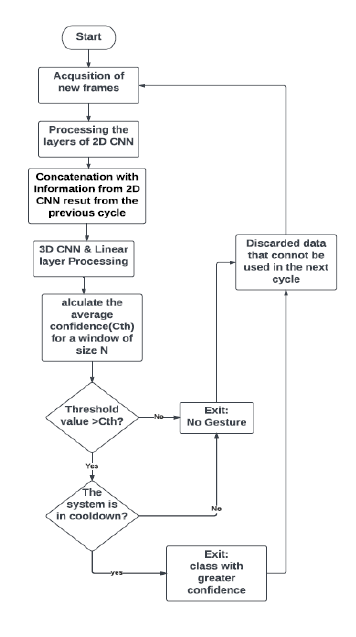
Fig 5. Flow of the